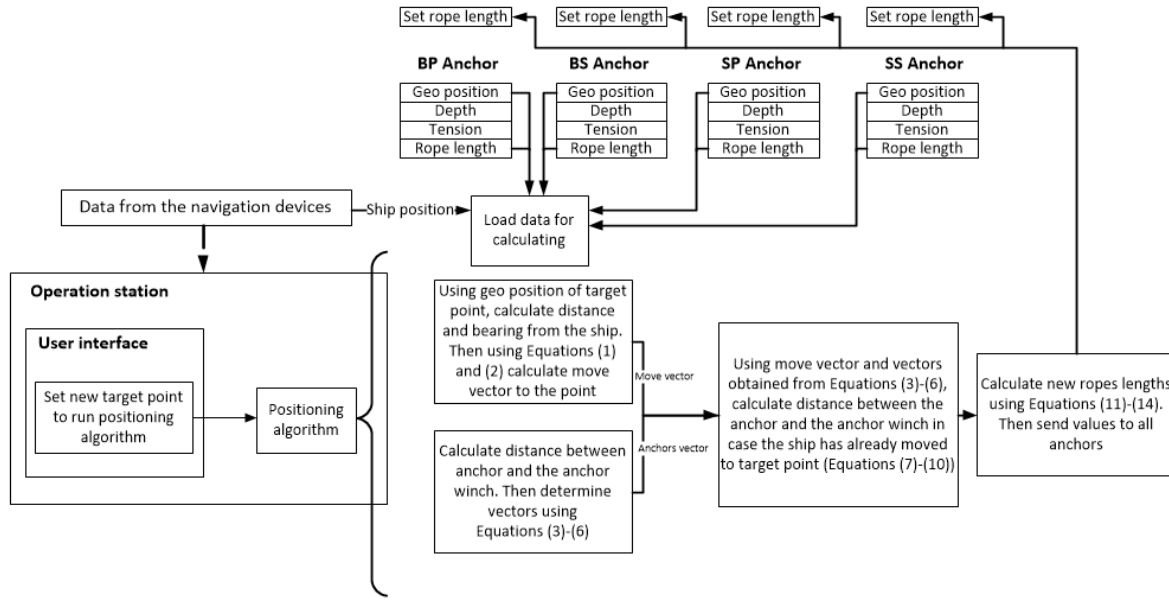
Figure 12. Visualisation of the ship’s trajectory.